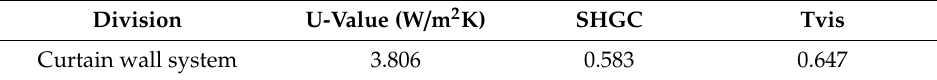
Table 3. Optical and thermal properties of the existing old curtain wall system.